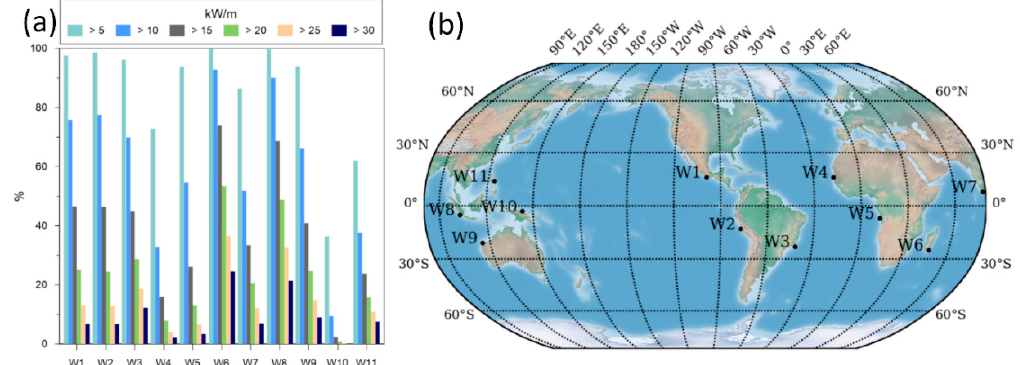
Figure 2. ( a ) Yearly availability percentage for 5, 10, 15, 20, 25, and 30 kW / m for the sites listed in Figure 2. (a) Yearly availability percentage for 5, 10, 15, 20, 25, and 30 kW/m for the sites listed in Table 1, ( b ) location of sites Table 1, ( b ) location of sites W1–W11.